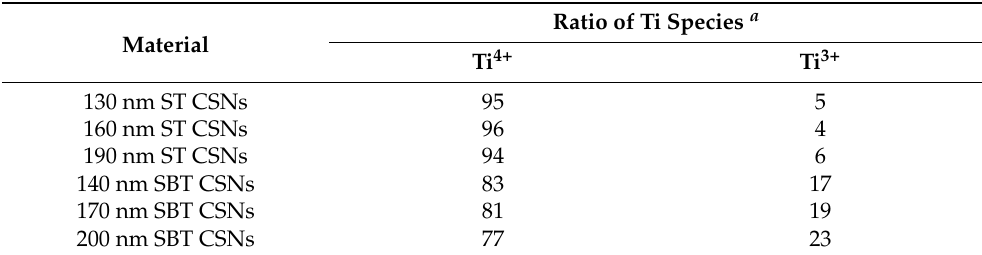
Figure 8. XPS Si 2p, Ti 2p, and O 1s level spectra of ( a ) 100 nm SiO 2 nanoparticles, ( b ) 130 nm ST CSNs, and ( c ) 140 nm SBT CSNs. Table 2. Ratios of Ti species of various-sized ST CSNs and SBT CSNs as determined from their Ti 2p spectra.